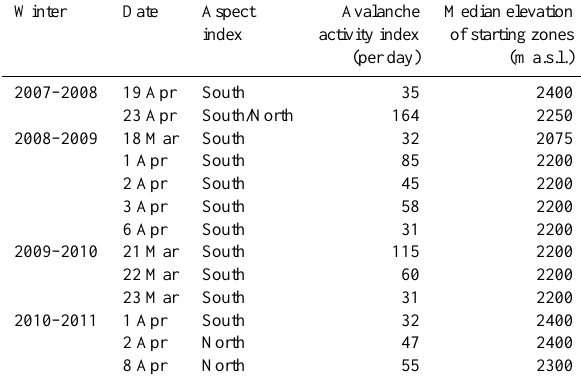
Table 1. Major wet-snow avalanche cycles (i.e. AAI > 30) in the surroundings of Davos, Switzerland, for the winters 2007–2008 to 2010–2011. Aspect index was calculated by relating the number and size of avalanches released on slopes of northern to those on south- ern aspects. Only for the cycle on 23 April 2008 no clear aspect could be assigned. Days with low activity are not included in